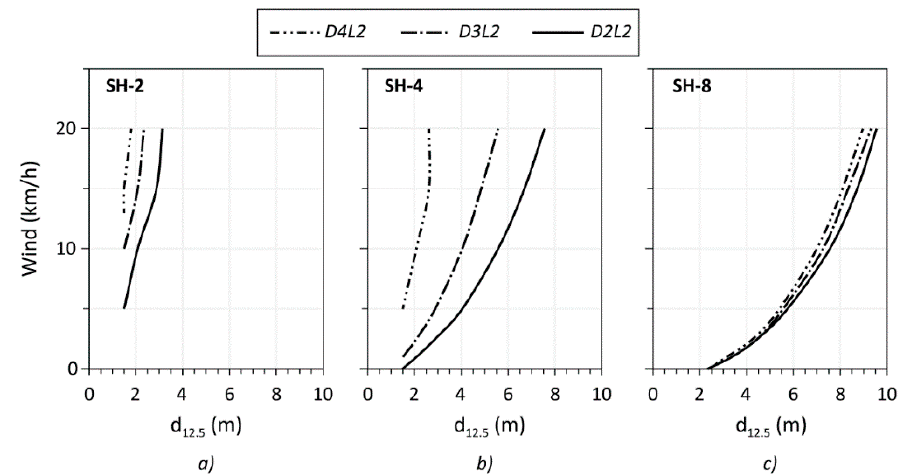
Fire 2022 , 5 , x FOR PEER REVIEW 17 of 22